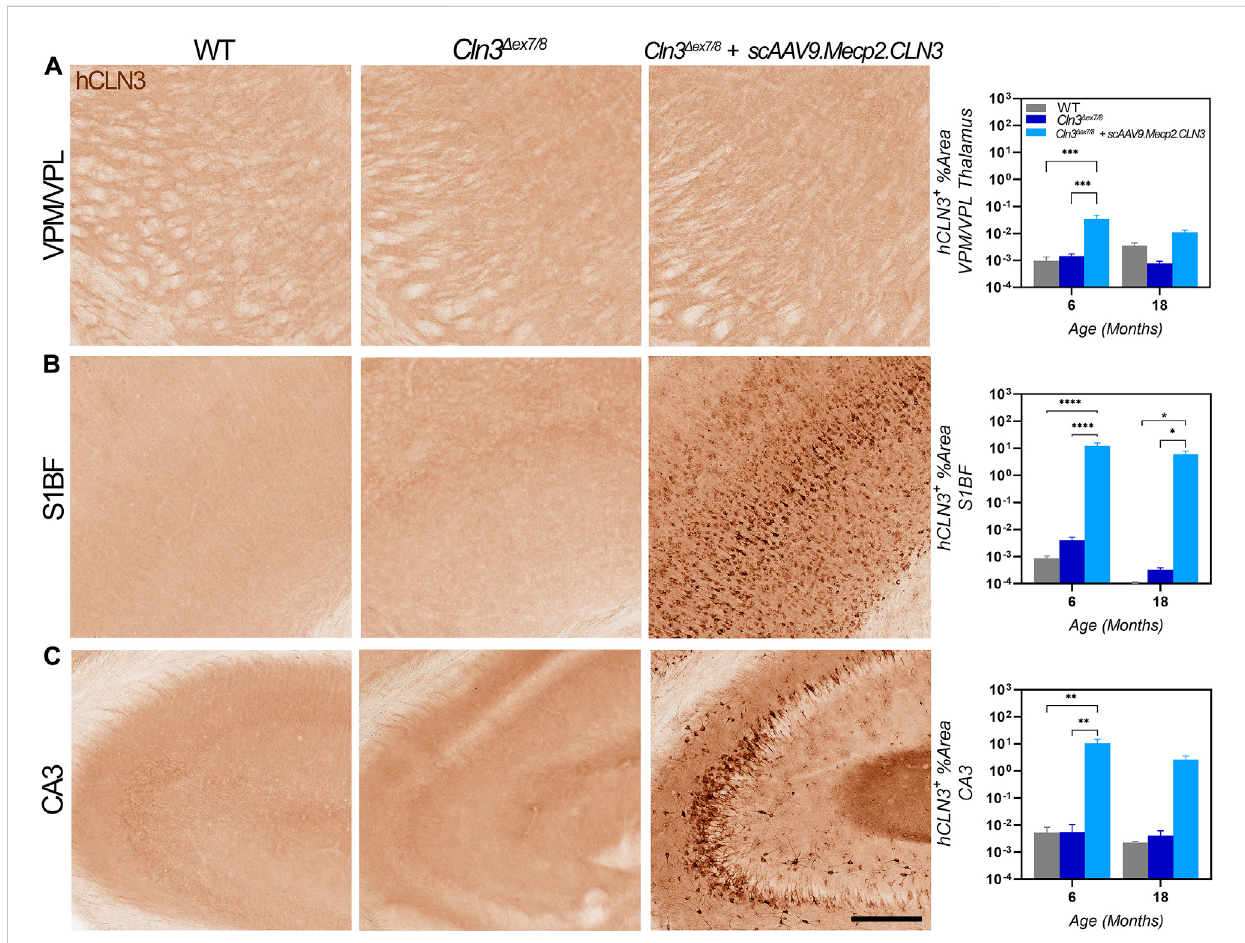
FIGURE 2 hCLN3 protein is expressed in the brains of scAAV9.Mecp2.CLN3 treated Cln3 Δ ex7/8 mice. AAV9 administration generates hCLN3 protein expression in the thalamus (VPM/VPL, (A) , somatosensory cortex (S1BF; (B) , and CA3 of the hippocampus (C) , most notably at 6 months of age. Two-way ANOVA, Tukey correction. Mean ± SEM. * p < 0.05, ** p < 0.01, *** p < 0.001, **** p < 0.0001. Scale Bar = 200 µm, images presented are from 6 months of age. 12 images/region/animal were